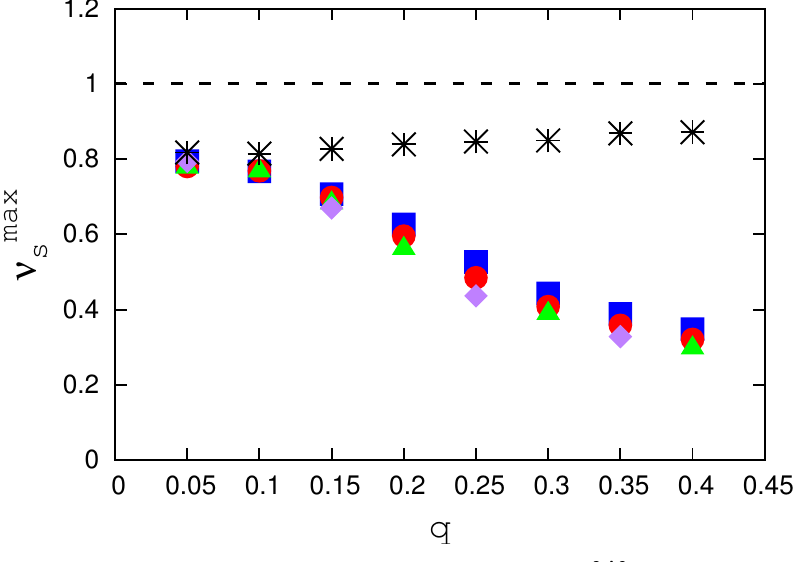
q ) of the saturated ion numbers as Figure 2. Normalized scaled maxima ν max s ( q ) = N max s / ( q 2 ˆ R 3 cut a function of trap control parameter q . The black dashed line indicates the static, filled-pseudo- potential expectation of the normalized particle number at saturation. The black stars are the ν max s ( q ) values obtained in the case where the rf-driven trap is replaced with its corresponding static pseudo- potential. The filled plot symbols are the ν max s ( q ) values resulting from full three-dimensional molecular-dynamics simulations of the trapped ions under the condition of constant-rate loading. Blue squares, red circles, green triangles, and purple diamonds correspond to ˆ R cut = 15,20,25,30, respectively. The approximate overlap of the plot symbols indicates near-perfect 1/ ˆ R 3 cut